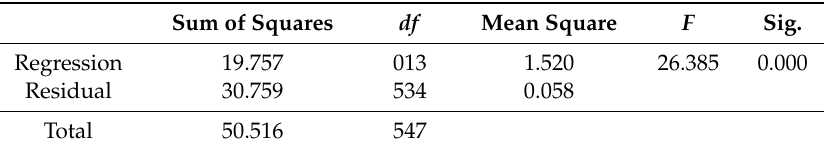
Table 5. ANOVA table for the developed MLR